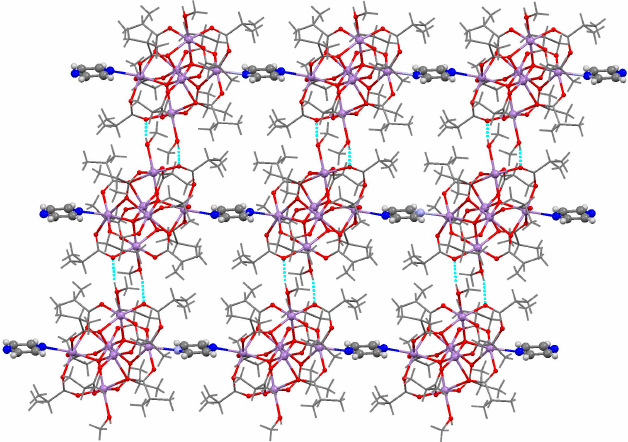
Figure 4. The fragment of the structure of 4 illustrates the incorporation of {Mn 6 } clusters into the 1D linear coordination polymer and hydrogen bonding of parallel polymeric chains into a layer. The bridging pyrazine molecules are shown by bigger radii balls.